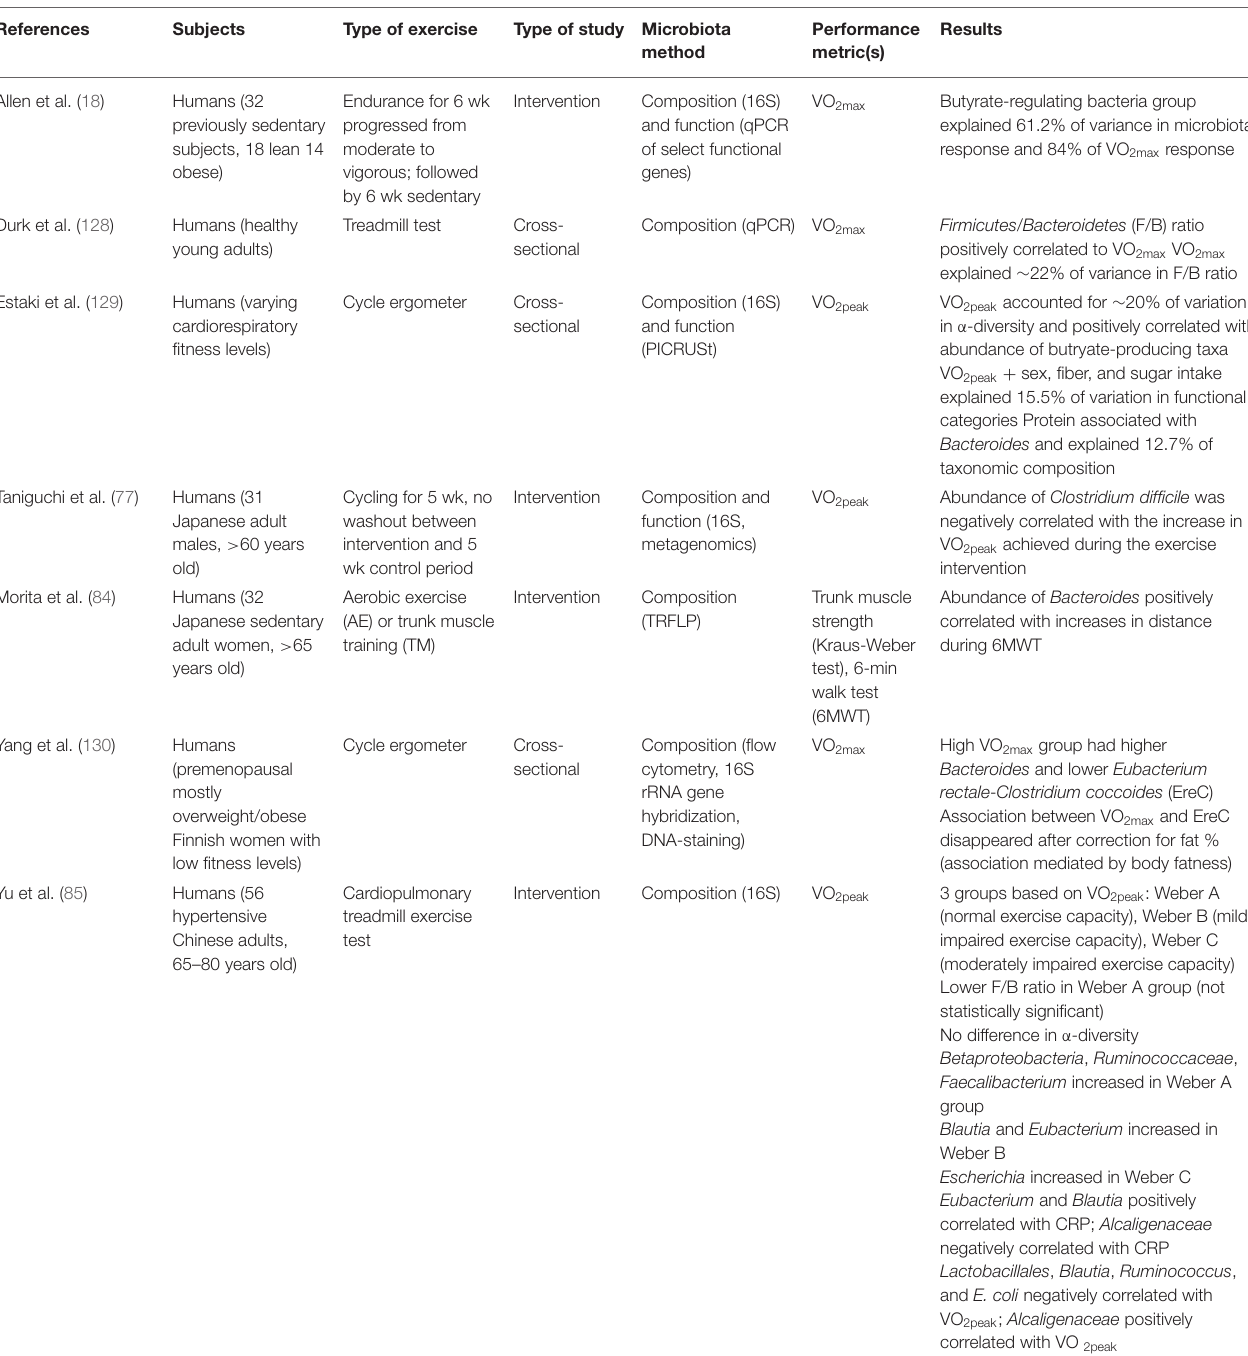
TABLE 3 | Summary of studies investigating the correlation between gut microbiota composition and measures of